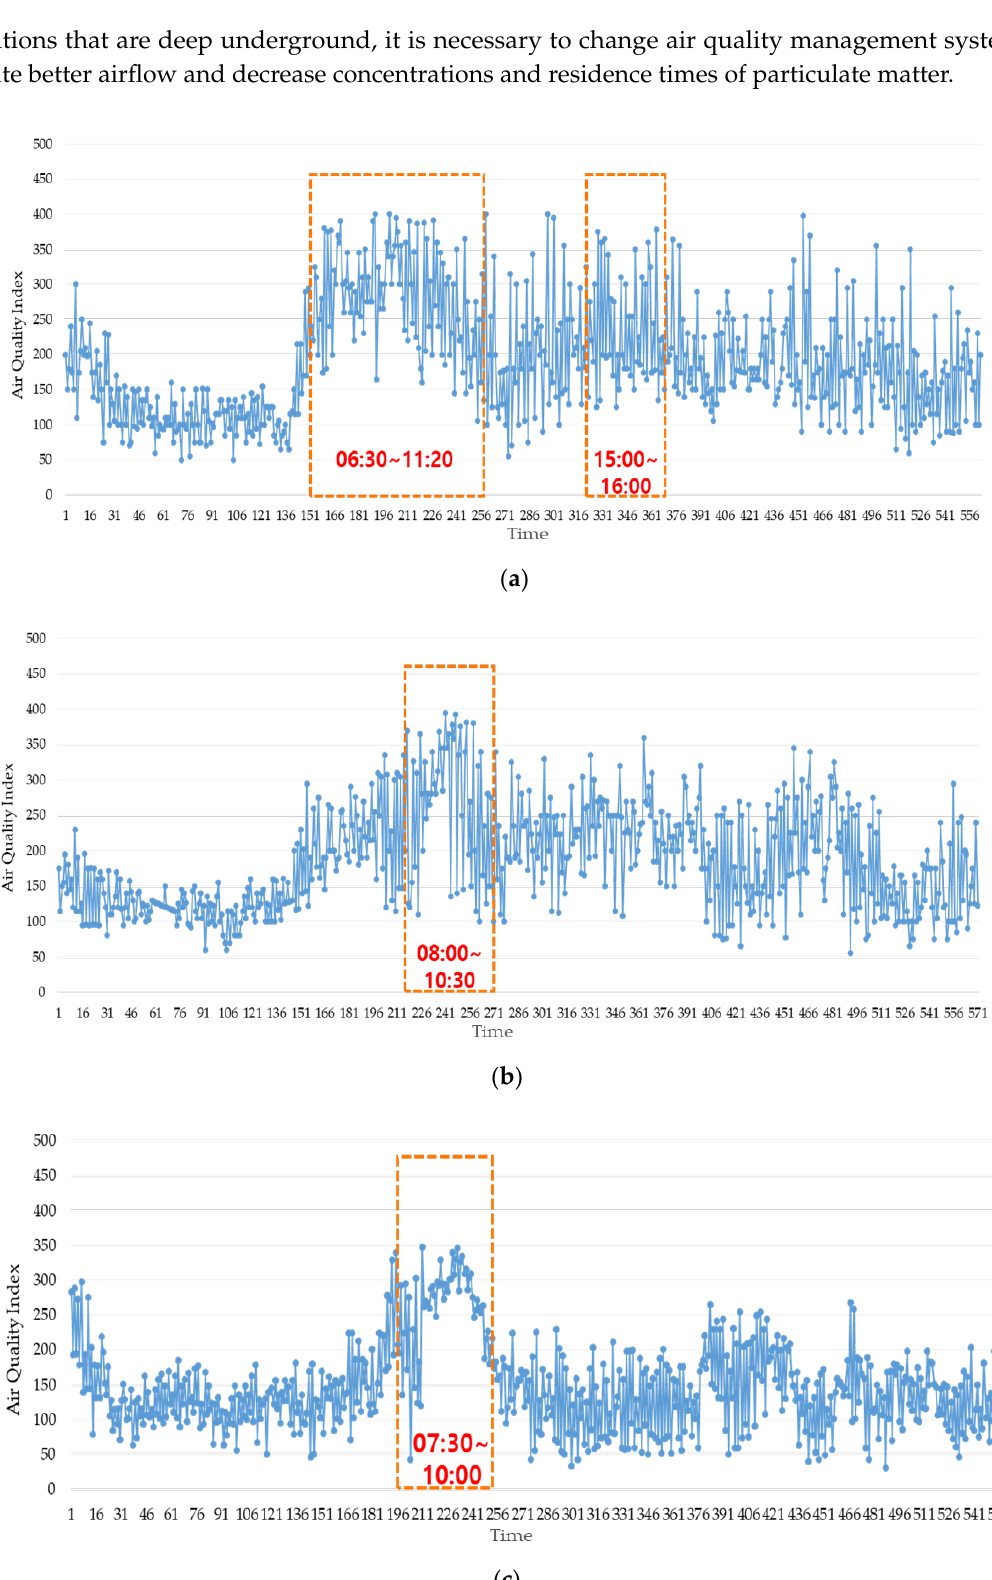
Figure 6. AQI for particulate matter (PM 10 ) measured in ( a ) Dongsu main ventilation room, ( b ) Bupyeongsamgeori station tunnel, and ( c ) Dongsu station tunnel.